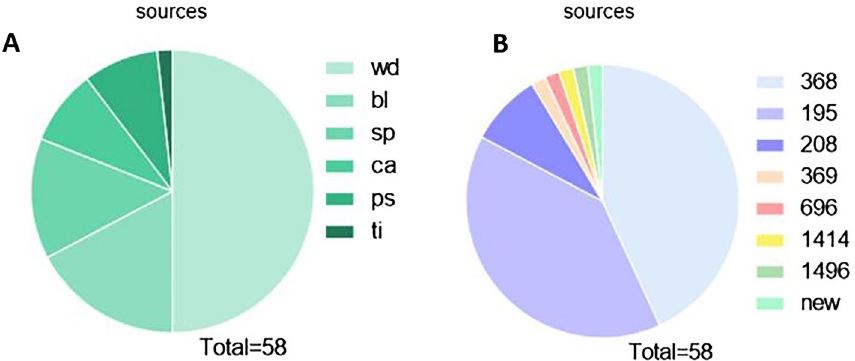
Figure 5. Characterization of 58 sensitive A. baumannii strains. ( A ) Sources of the 58 strains. wd (wound surface), sp (sputa), ca (catheter), bl (bloodstream), ps (purulent secretion) and ti (tissue); ( B ) STs identified among 58